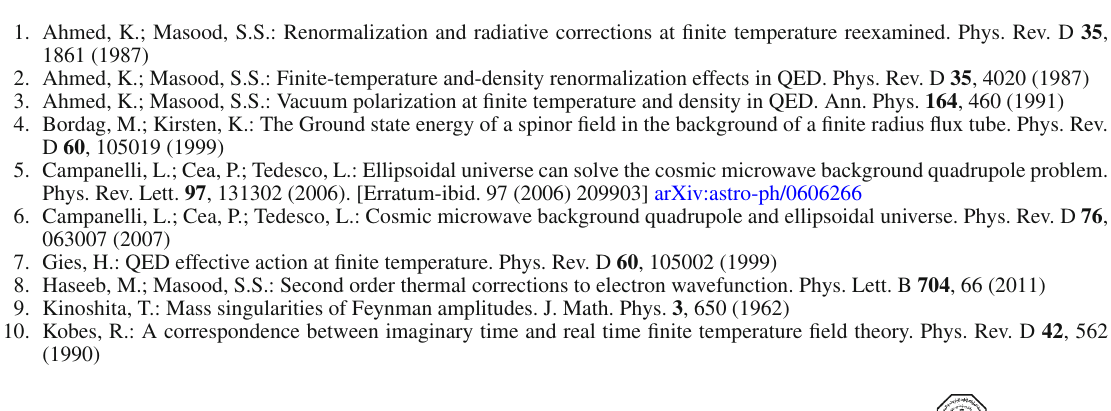
A plot of plasma parameters in Fig. 4 shows that the Debye length decreases with increase in